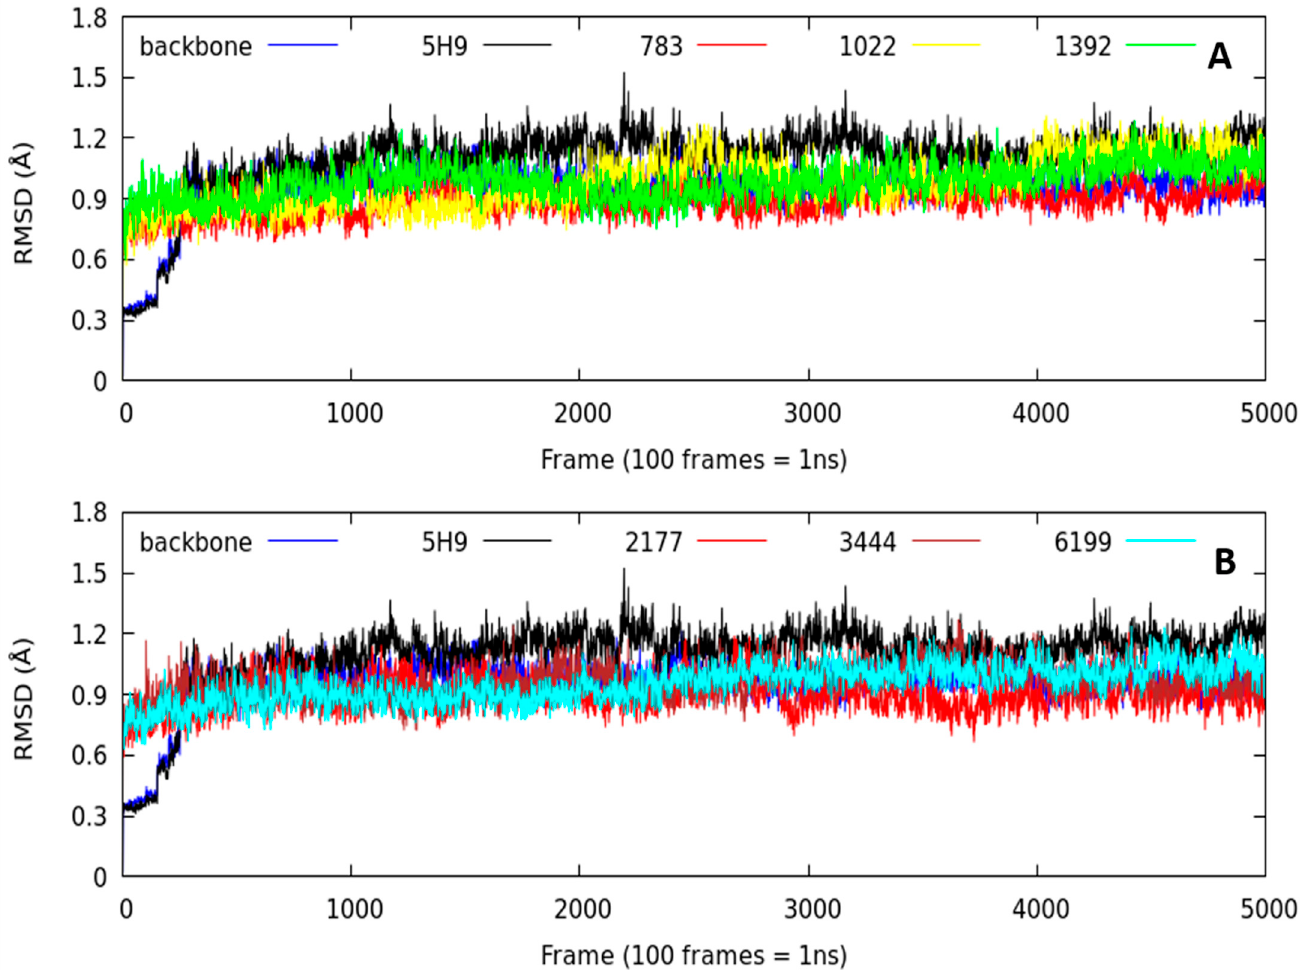
Figure 4. Comparative plots of RMSD values against simulation time corresponding to the molecular dynamics of the backbone, 5H9 ligand reference, and molecules designed in silico-thermolysin complexes. ( A ) is the comparison between backbone, 5H9, Lig783, Lig1022, Lig1392; ( B ) is the comparison between backbone, 5H9, Lig2177, Lig3444, Lig6199.